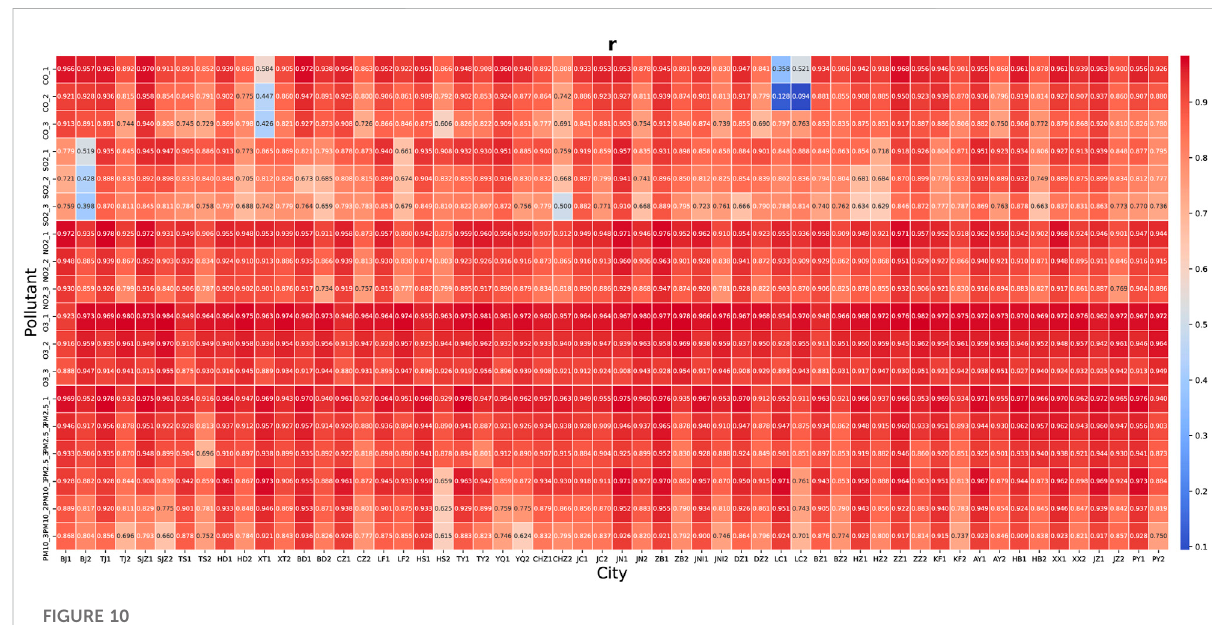
FIGURE 10 The r of pollutant concentration prediction of TSTM in “ 2+26 ”